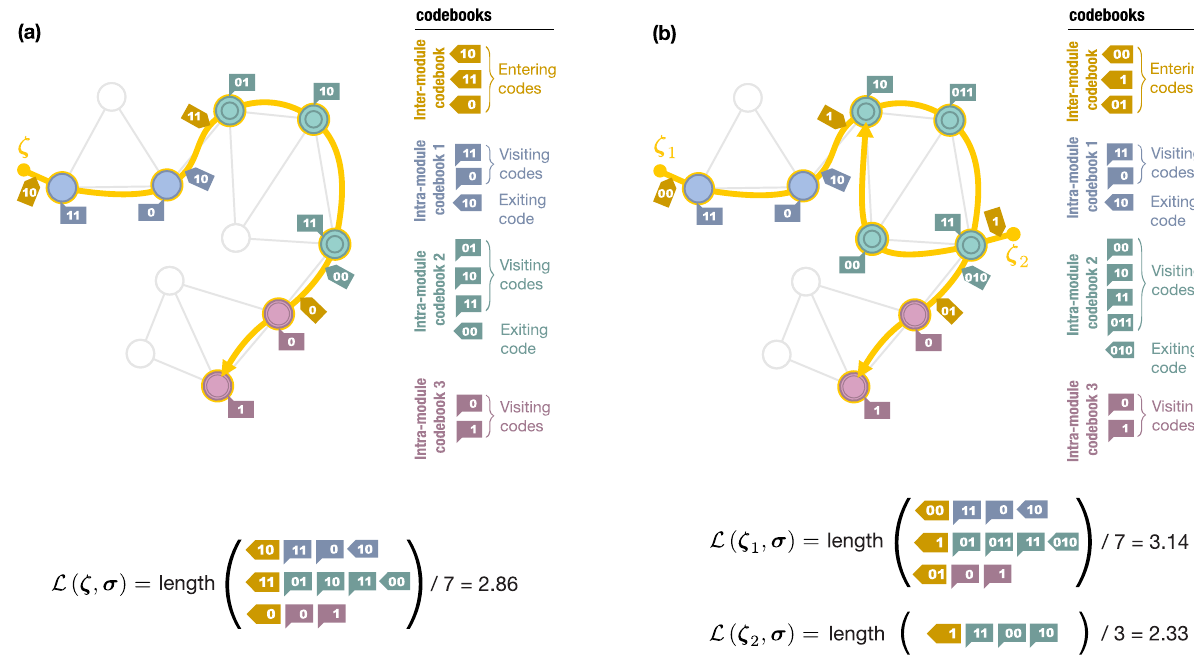
Figure 2. Trajectories (yellow solid lines) on a network and their encoding for a given node partition. Nodes in the same module have the same symbol and colour representations. The codewords in each codebook are listed on the right. Whereas there is only one trajectory in ( a ), another trajectory is added in ( b ). The average code length of each trajectory is shown at the